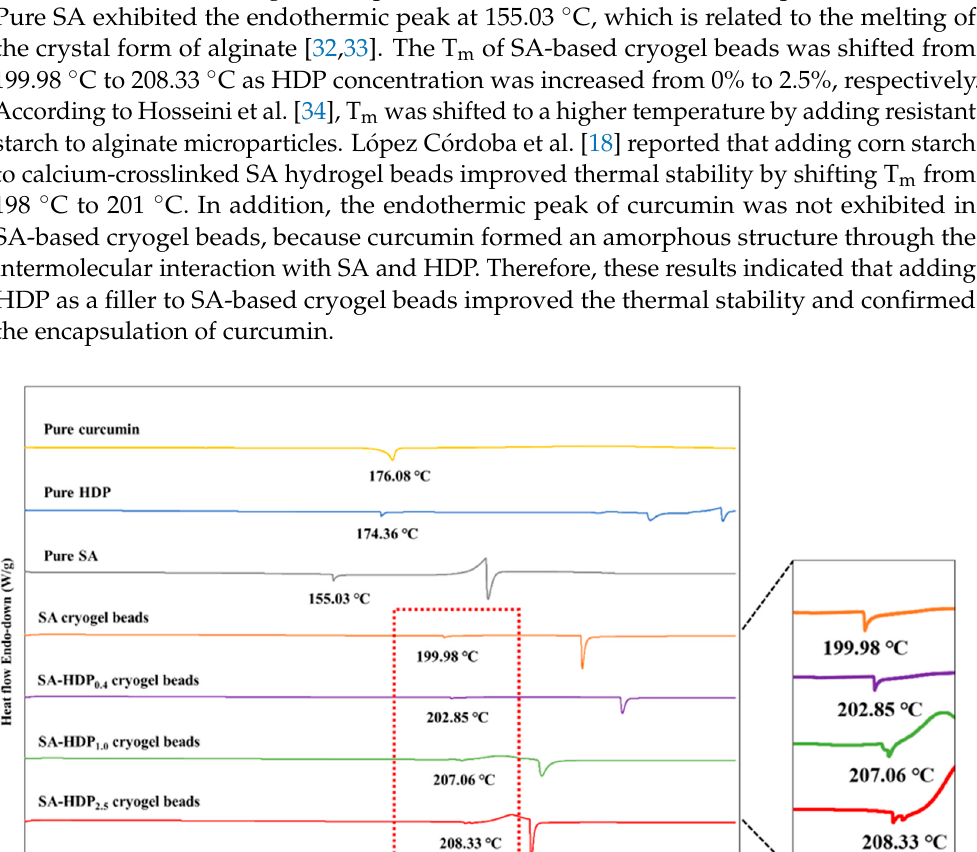
Figure 2. X-ray diffraction (XRD) patterns of pure curcumin, pure hydroxypropyl distarch phosphate (HDP), pure sodium alginate (SA), and SA-based cryogel beads filled with different concentrations of HDP. SA cryogel beads, SA-HDP 0.4 cryogel beads, SA-HDP 1.0 cryogel beads, and SA-HDP 2.5 cryogel beads represent cryogel beads filled with different concentrations of HDP (0, 0.4,